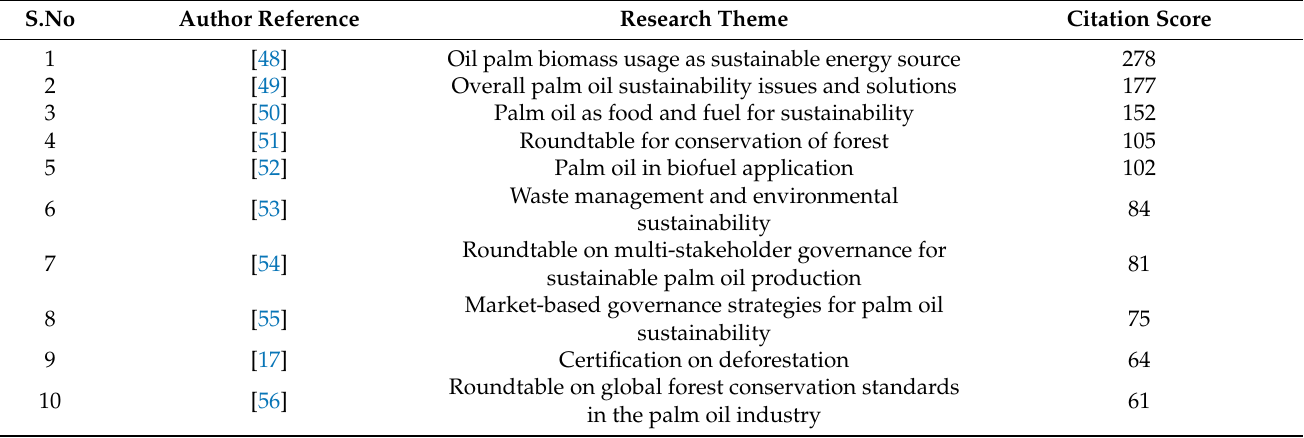
Table 3. Top ten highly cited